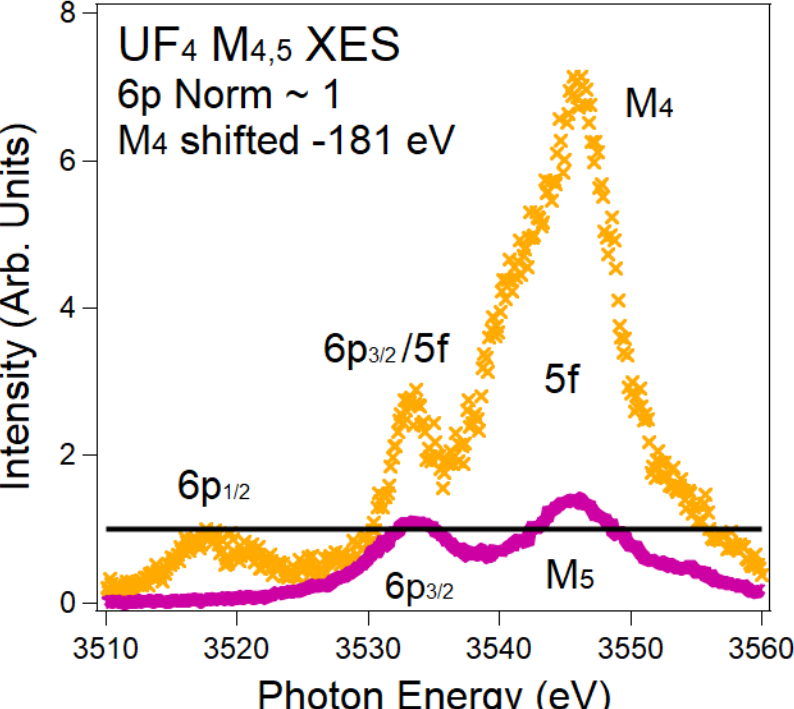
Figure 12. The M 4 (3d 3/2 hole) and M 5 (3d 5/2 hole) XES spectra of UF 4 are shown here. The spectra have been normalized to the M 4 6p 1/2 (p 1/2 → d 3/2 , Δ j = 1) and M 5 6p 3/2 (p 3/2 → d5/2, Δ j = 1) peaks. Orange X = M 4 . Purple line = M 5 . Black line = unity (1) for 6p normalization. The M 4 spectrum has been shifted –181 eV to align the peaks on the M 5 energy scale. The 6p 1/2 : 6p 3/2 intensity ratio = 0.8, following the electric dipole cross sections. Note the very large enhancement of the 5f peak in the M 4 spectrum relative to that of the M 5 spectrum. See text and Reference [26] for details. Similar to Figure 1 in Reference [26].